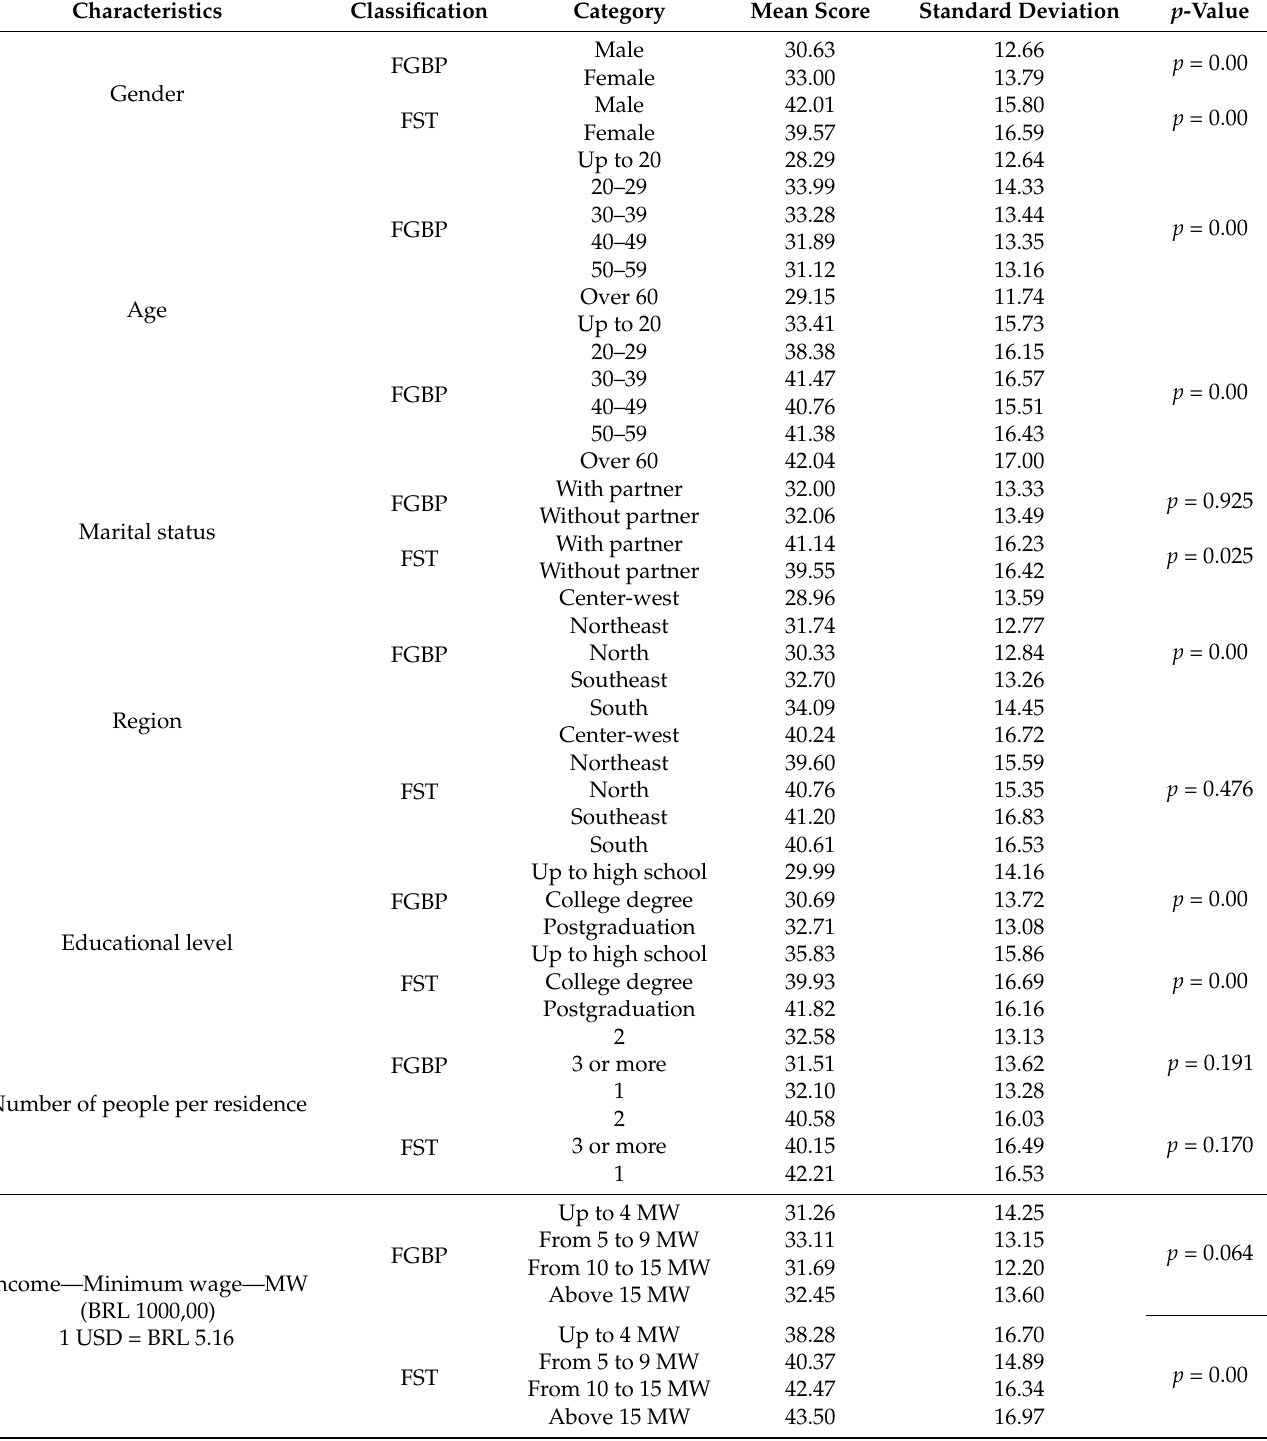
Table 3. Relationship between the mean score (%) and the standard deviation for respondents who classified food according to the definitions of the Food Guide for the Brazilian Population (FGBP) and the definitions of food classification according to food science and technology (FST).